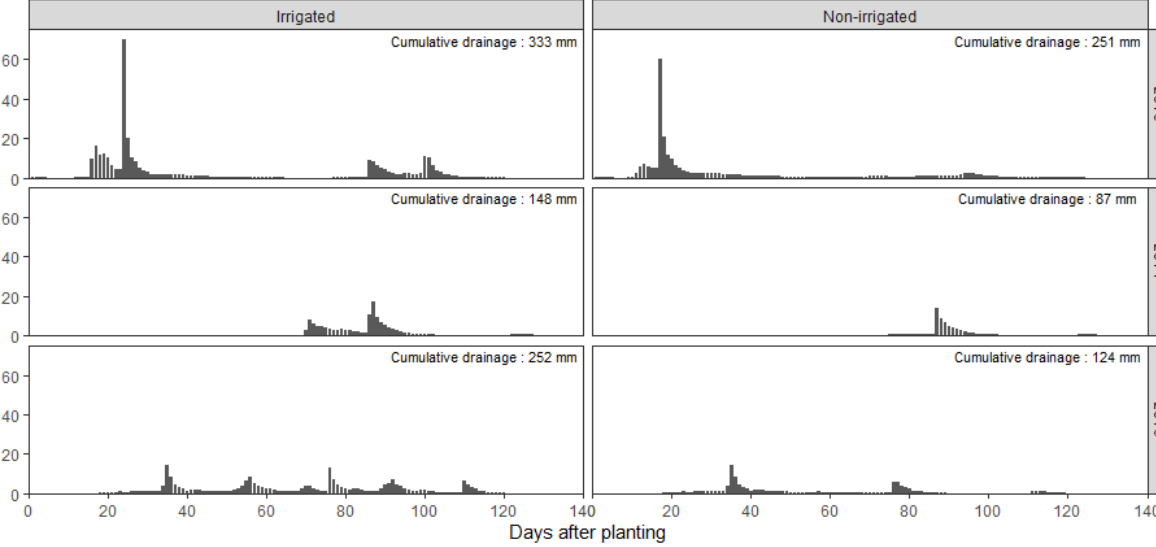
Figure 3. Water drainage during the growing season at the irrigated and non-irrigated sites in 2013, 2014, and 2015. Higher FWNC was measured for PCU + urea compared to PCU without irrigation, whereas no statistical difference was found between PCU and PCU + urea under irrigation. A priori contrasts showed no significant difference in FWNC between the CONV treatment and PCU or PCU + urea applied at the equivalent N rate (200 kg N ha − 1